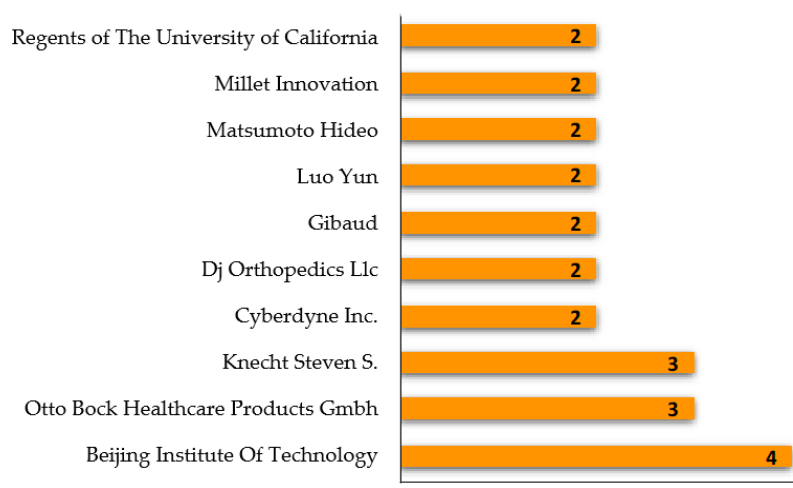
Figure 5. Top patent applicants for exoskeletons and orthosis.